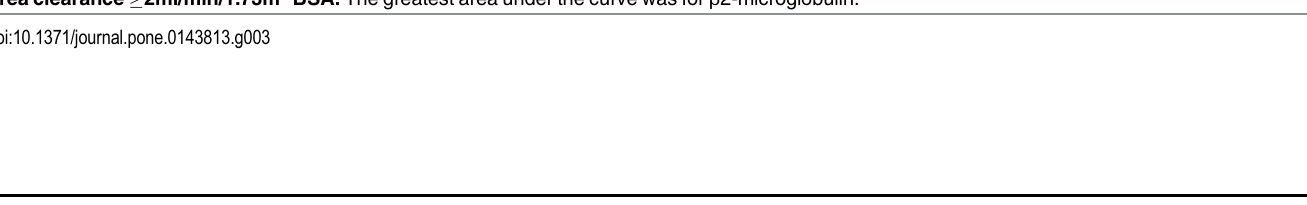
PLOS ONE | DOI:10.1371/journal.pone.0143813 December 2,